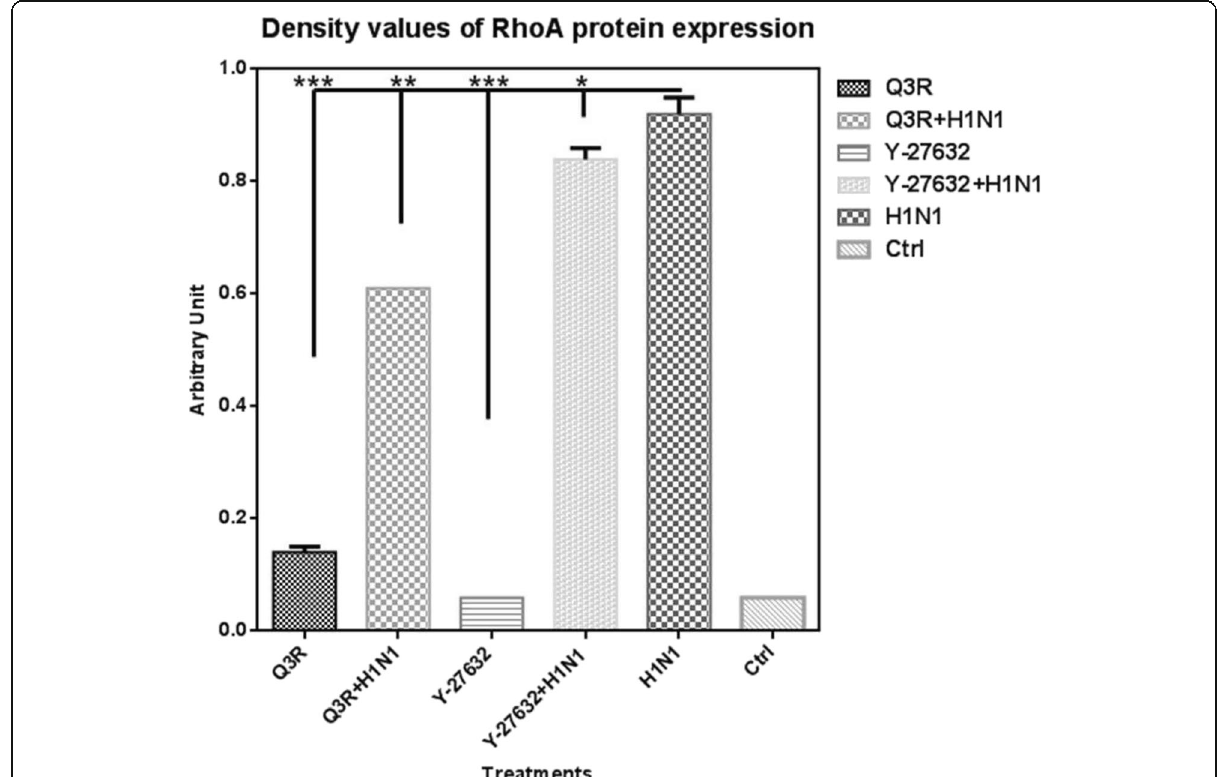
Fig. 3 Density values of RhoA protein expression. Values show the density of the RhoA protein bands normalized to the related housekeeping protein ( β -actin) quantified by ImageJ. (*** P ≤ 0.001; ** P ≤ 0.01; * P ≤